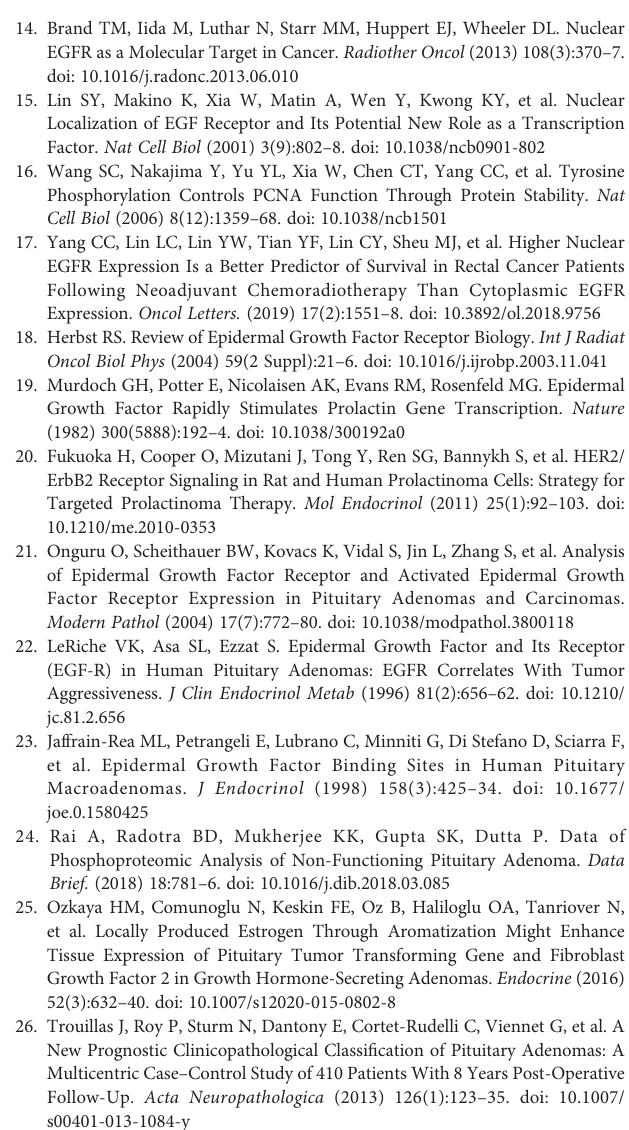
parameters (A – E) showed no differential expression across age (A) , gender (B) , immunohistochemistry ofhormones (C) , andTrouillas classi fi cation (D) .Proliferative tumors as per Trouillas classi fi cation (1b + 2b) showed signi fi cantly higher expression of pEGFR T 693 as compared to non-proliferative NFPAs (1a+2a) (E) . Age group(A)- 1: <30 years, 2: 30-50years, 3: >50 years .SA,silent adenoma; GN, gonadotropinoma; NC, null cell adenoma. Supplementary Figure 3 | NFPAs quantitative h-score of pEGFR T693 immunohistochemistry with tumor size and extension (A – E) showed no differential expression across tumor diameter (A) , tumor volume (B) , suprasellar extension (C) , parasellarextension (D) ,andinfrasellarextension (E) .TheStudent ’ st-testwasused for comparing the groups. SSE-suprasellar extension, PSE-parasellar extension, ISE-infrasellar extension. Supplementary Figure 4 | EGFR expression in NFPAs (n=50). Positive EGFR expression was observed in two patients (D) and while others were negative (E) . Cervical carcinoma was used as the positive control (A) while there was no expression of EGFR in normal pituitary (n=5), Cushing ’ s (n=10), and negative control. Magni fi cation